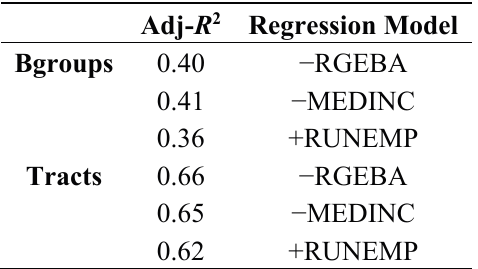
Table 1. Regression models with the highest adjusted- R 2 values.